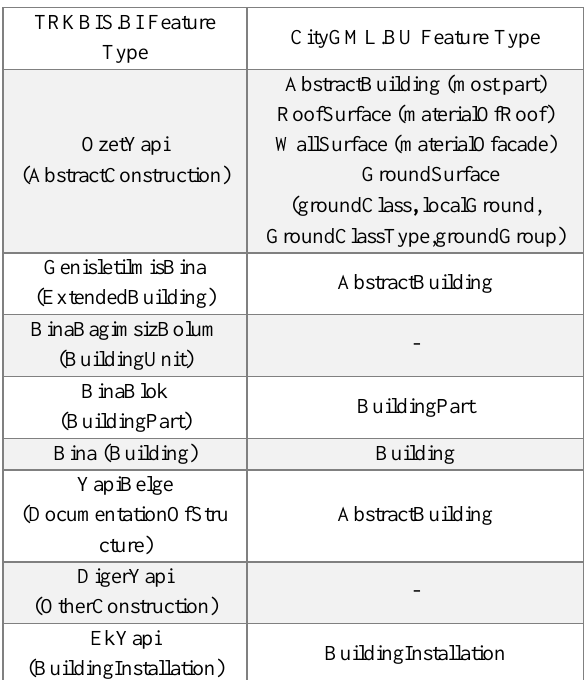
Figure 5. Classes that are existing in TRKBIS model and added to CityGML model.